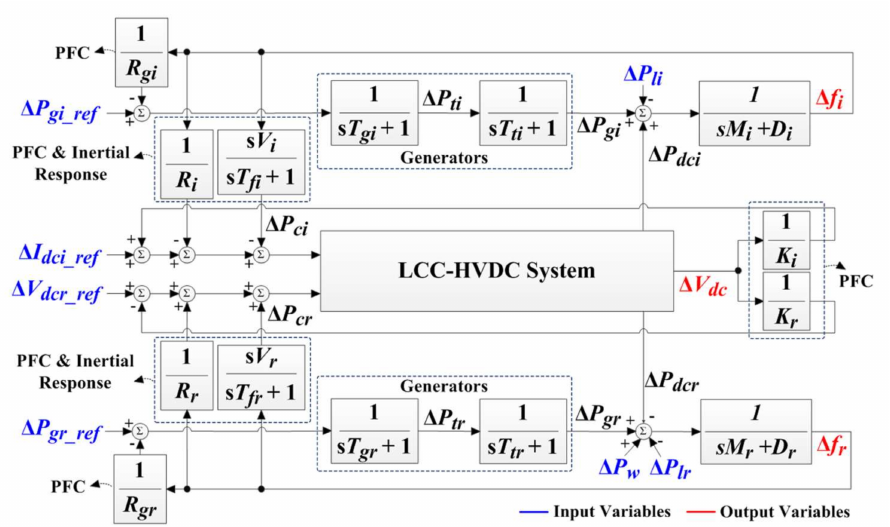
Figure 3. A small-signal model of HVDC-linked grids considering the dynamics of the DC link, the converters, and the inner feedback